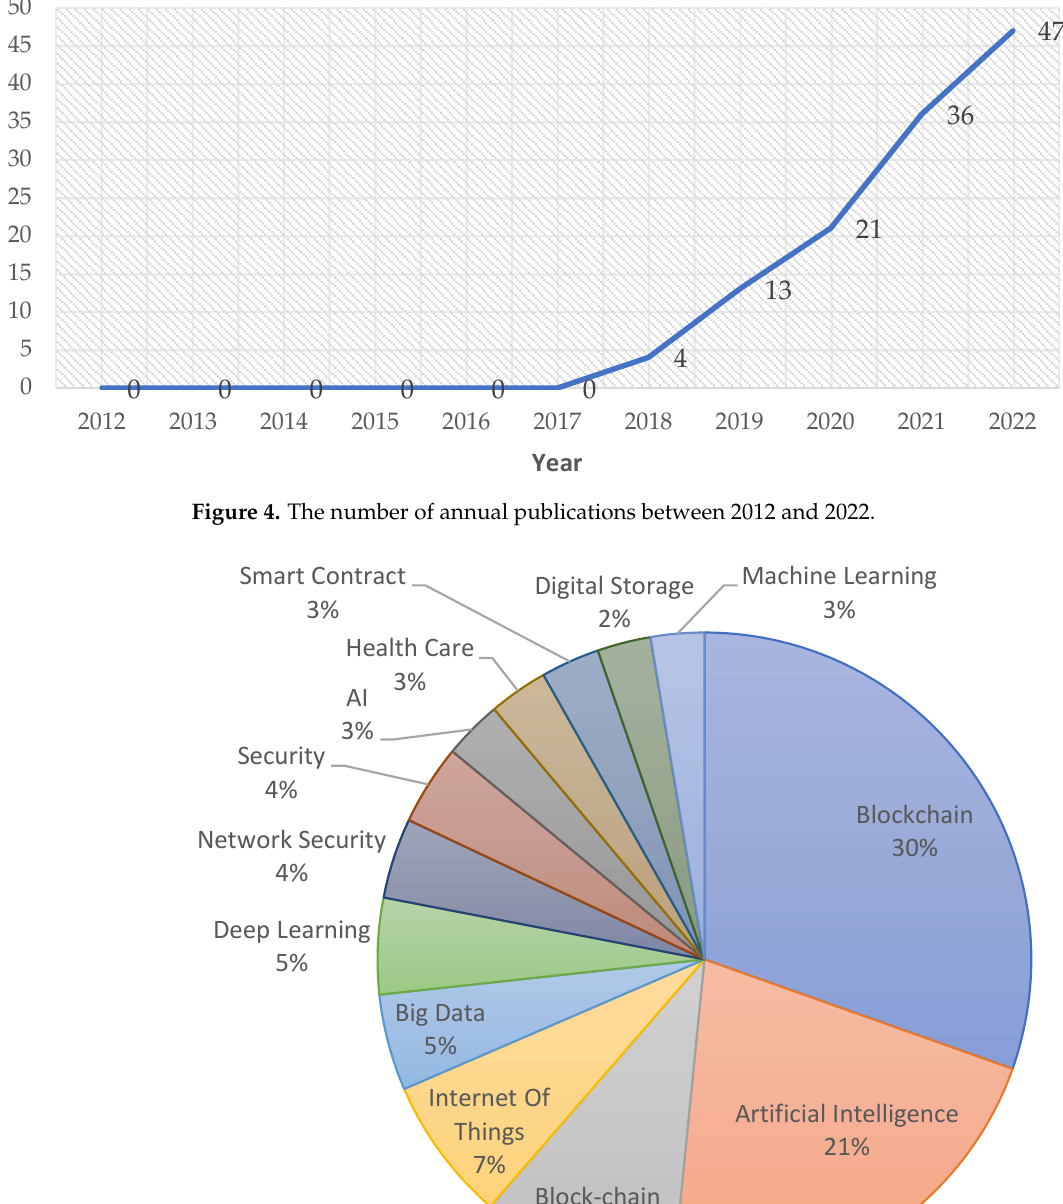
Figure 4. The number of annual publications between 2012 and 2022.